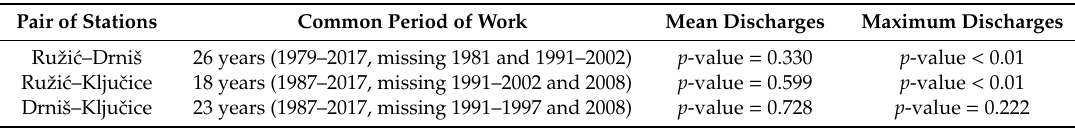
Table 2. Results of t -tests for average mean and maximum annual discharges between the three pairs of hydrological stations during common periods of their